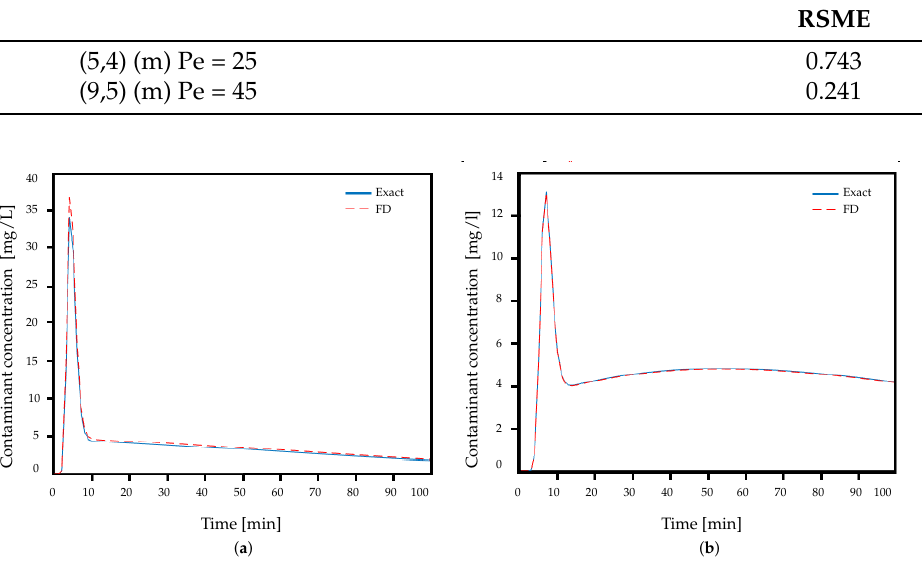
Table 4. Error measures of the contaminant concentration profile plots of Figure 6.